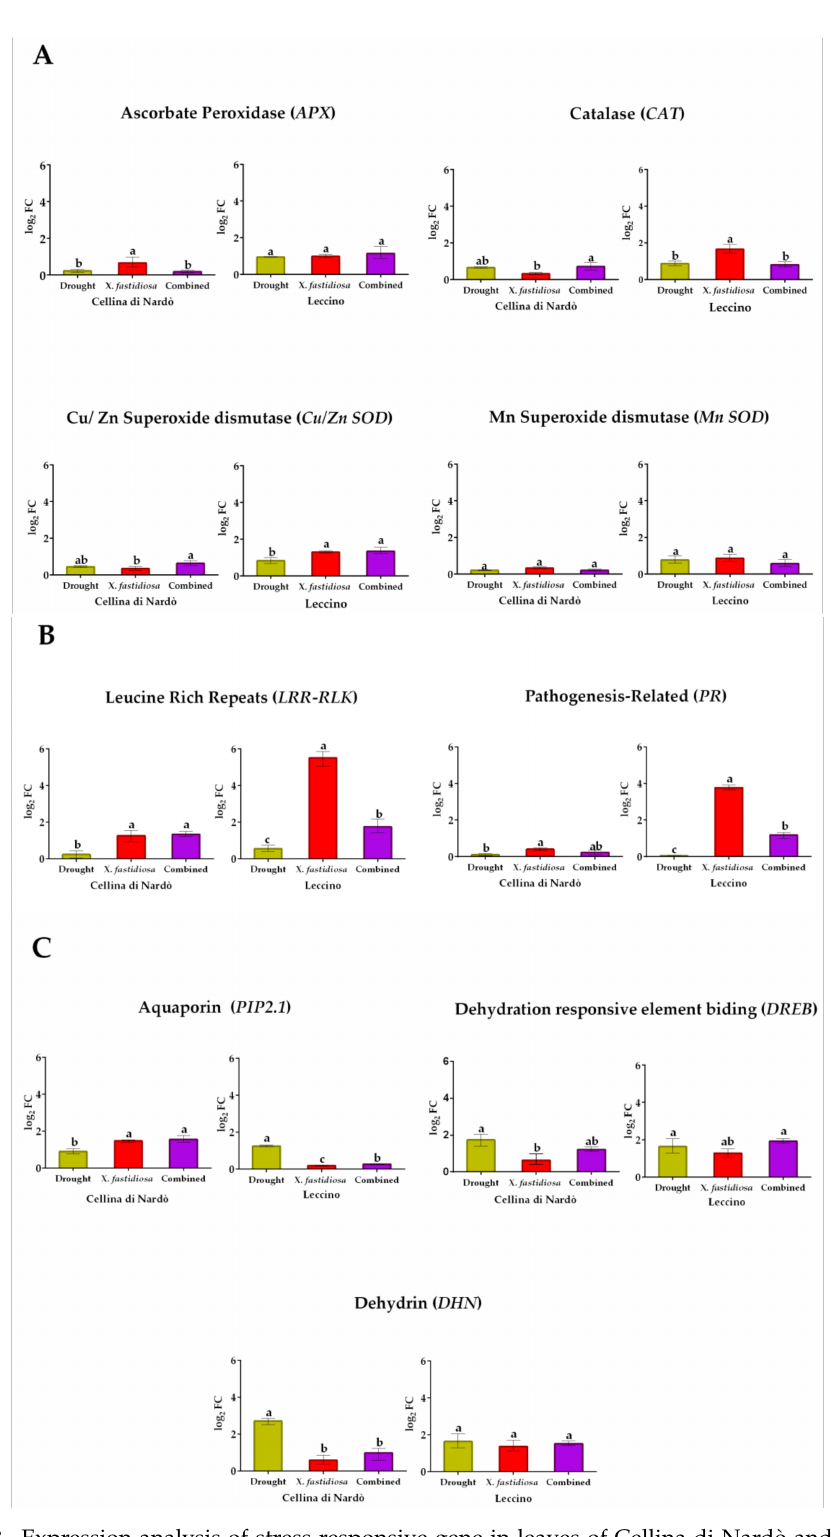
Figure 3. Expression analysis of stress responsive gene in leaves of Cellina di Nard ò and Leccino cultivars subjected to stresses: drought, pathogen Xylella fastidiosa and combination of both, expressed as log 2 fold change (log 2 FC). ( A ) genes related to oxidative stress: superoxide dismutase ( Cu / Zn SOD and MnSOD ), catalase ( CAT ), ascorbate peroxidase ( APX ), ( B ) genes related to pathogen stress: leucine rich repeats- receptor like kinase ( LRR-RLK ) and pathogenesis-related protein 1-like ( PR ). ( C ) genes related to drought responses: aquaporin ( PIP2.1 ), dehydration responsive element binding ( DREB ) and dehydrin ( DHN ). Statistical analysis was carried out through one-way ANOVA with Tukey-HSD post hoc test. Di ff erent letters correspond to statistically di ff erent